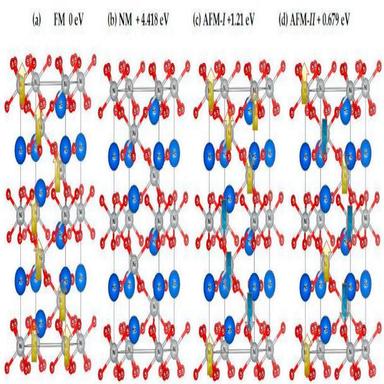
Total energies of the FM, NM, AFM-I and AFM-II states of rhombohedral R3c-type HoNiO3 for its 1 � 1 � 1 unit cell.